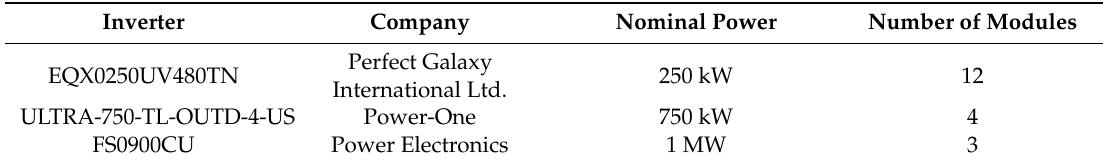
Table 11. Number of modules to achieve 3 MW with the inverters under study.